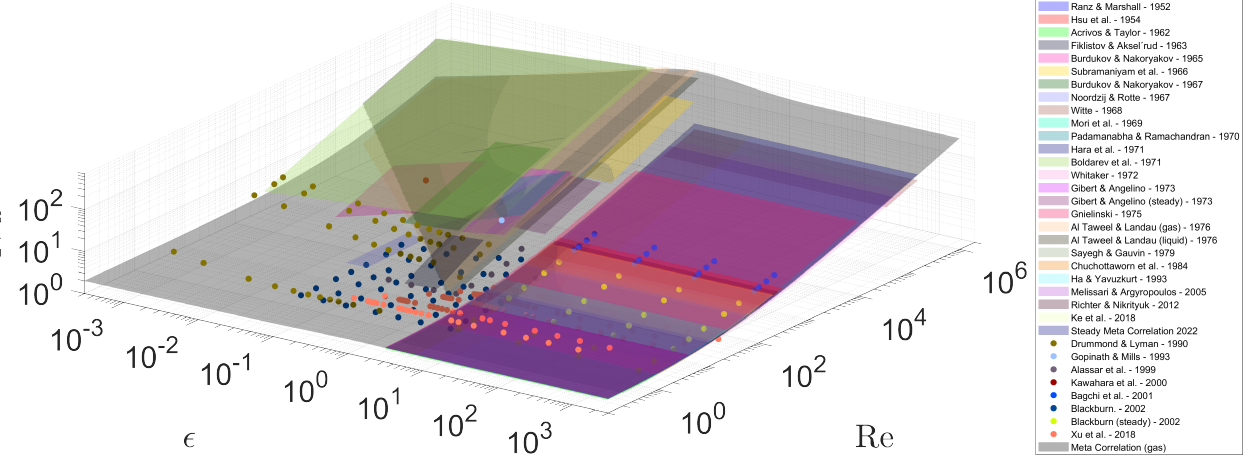
Figure 4. Nusselt number averaged over the particle surface and averaged over one oscillation cycle predicted by various investigated models plotted in the (cid:101) - Re plane. Additionally, Meta-Correlation (4) for gaseous environments is plotted, while the Prandtl number is set to Pr = 0.71 as can be found with air at